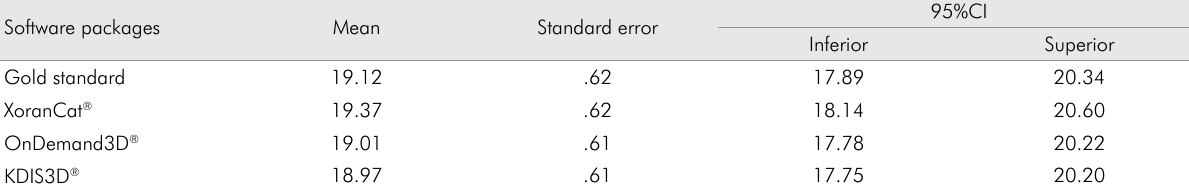
Table 1. Measurements (in mm) of the gold standard and using the three software packages.